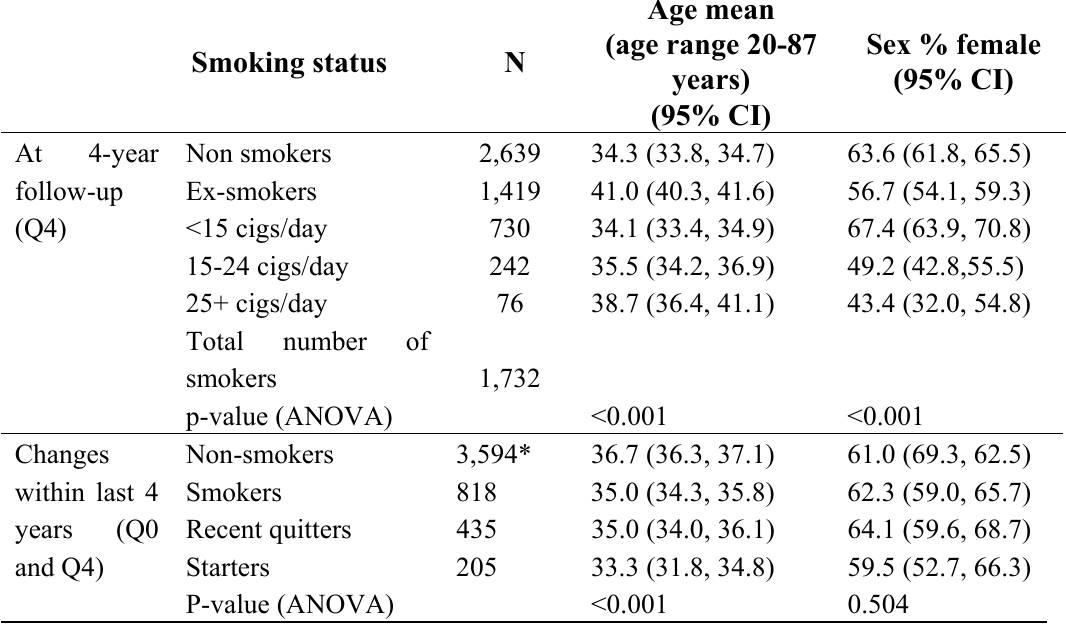
Table 1. Age (in years) and sex distribution (in % females) by smoking status and changes in smoking status. SUN study participants, N=